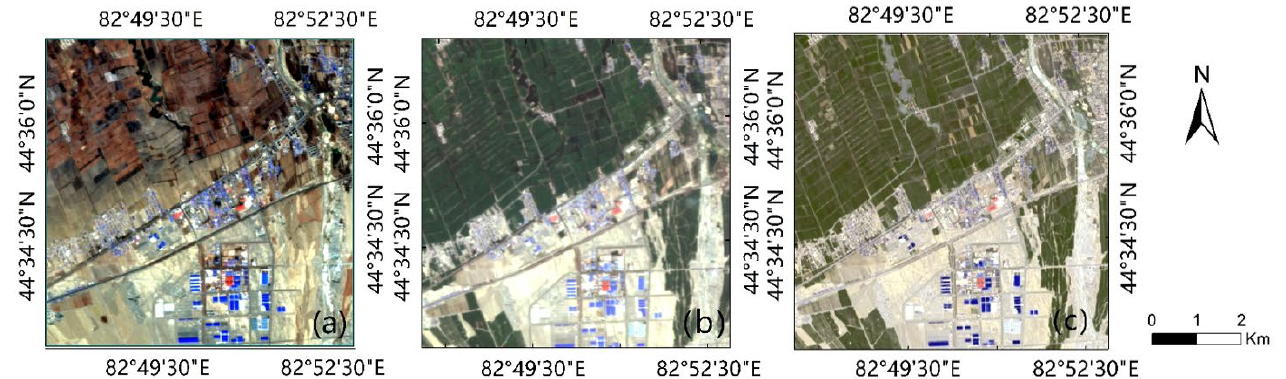
Figure 3. The location of region A.